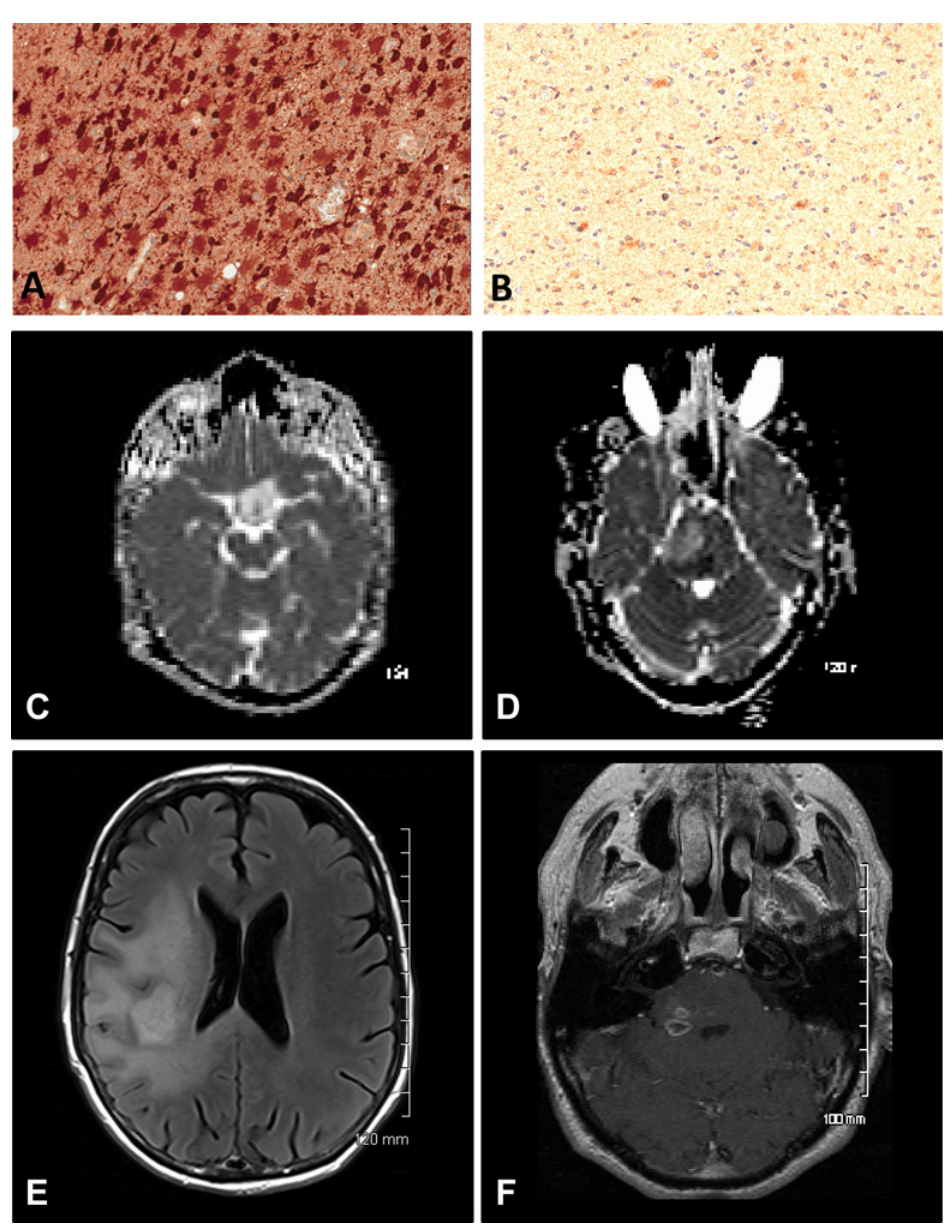
Fig 1. Pathological and radiological differences between IDH1-R132H positive and IDH1-R132H negative tumours. A and B: Immunohistochemical staining was used to identify IDH1-R132H positive tumours which demonstrated intense cytoplasmic staining (A) relative to the unstained tumour cells in IDH1-R132H negative tumours (B). C and D: An IDH1-R132H positive tumour (C) demonstrating a higher minimum ADC relative to an IDH1-R132H negative tumour (D). E and F: An IDH1-R132H positive tumour (E) demonstrating a greater volume of contrast-enhancing tumour relative to an IDH1-R132H negative tumour (F).